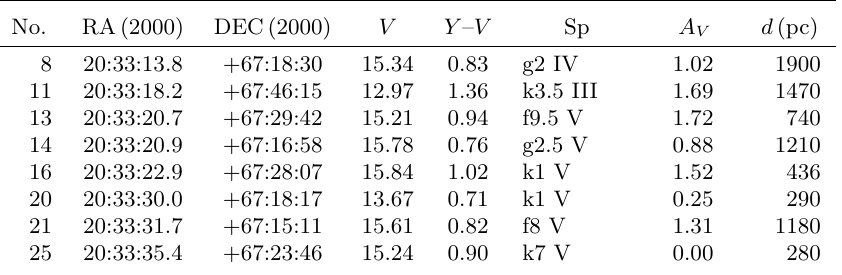
Table 1. Stars in the investigated area with most reliable spectral types deter- mined from Vilnius photometry.